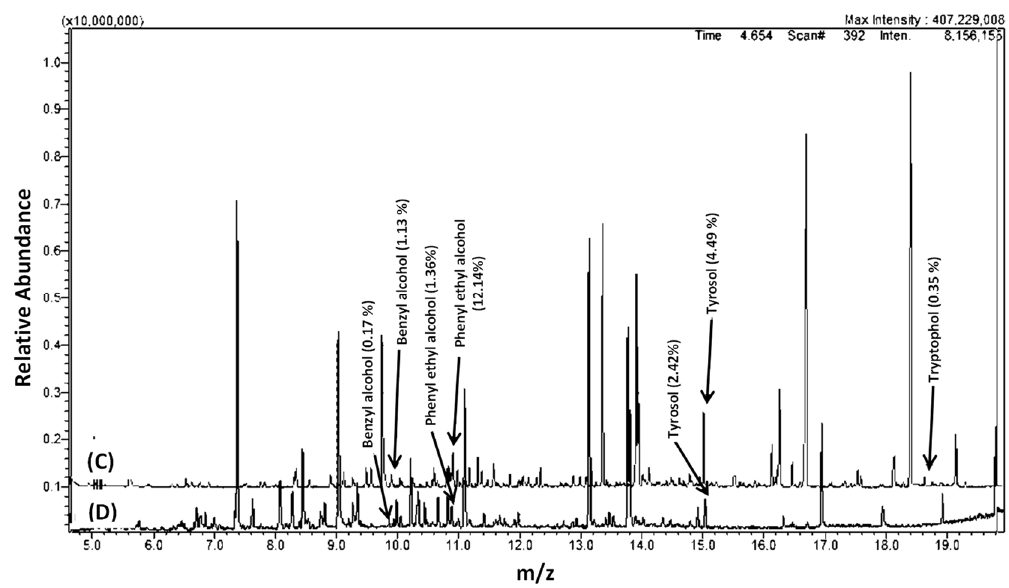
Figure 2. GC-MS chromatograms of Candida cultures extracts. Chromatograms of ( A ) C. albicans ATCC10231 strain compared to ( B ) C. auris (CAU09) strain. ( C ) and ( D ) GC-MS chromatograms of C. auris CAU09 at two different growth stages ( C ) 16 h compared to ( D ) 4 h incubation periods representing the differences in metabolites abundance. CAU09 was used as a representative to C. auris strains since all C. auris strains showed a similar pattern of GC-MS analysis (data not shown). Cell-free supernatants were collected, extracted by chloroform and derivatized by MSTFA and TMS prior to GC-MS analysis using GC-2010 coupled with a GC–MS QP-2010 Ultra.